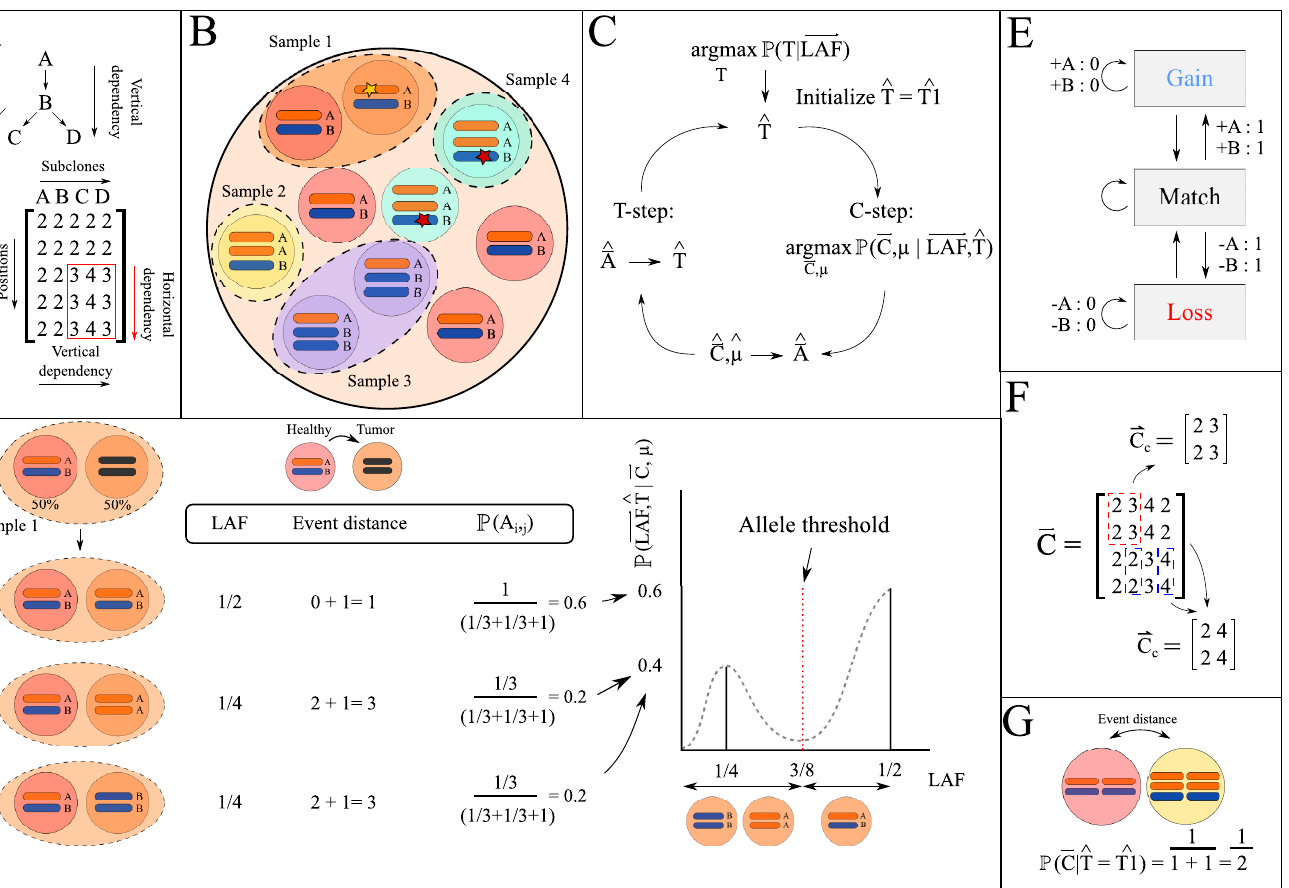
Fig 1. Overview of the TargetClone methodology. (A) A vertical dependency exists between subclones A-D. In red a horizontally dependent region is highlighted. (B) Multiple subclones with different somatic mutation patterns are sampled from a tumor. Sample 1 contains a mixture of tumor cells and healthy cells, while sample 2, 3 and 4 only contain tumor cells. A star indicates a somatic SNV. (C) General overview of the iterative optimization used in TargetClone. (D) A sample containing healthy cells and a tumor component (each present in 50% of the sample) with a copy number of 2 can be explained by 3 possible scenarios (see left) that each result in a different LAF measurement. Each scenario is scored using the event distance to generate a probability distribution (right). The alleles of the tumor component can be derived from the probability distribution. (E) The FST used to compute the event distance between subclones. Every allele can be gained or lost, which is assigned a distance of 1. If the adjacent position is affected by the same event, the distance is not increased further, which is indicated by the loops to the same state. (F) Two ~ ð C with a different combination of parent and child subclone are highlighted with the blue and red dashed lines. (G) Computation of P ð ~ C j ^ T Þ for two adjacent alleles. Using the horizontal dependency, the event distance equals 1.